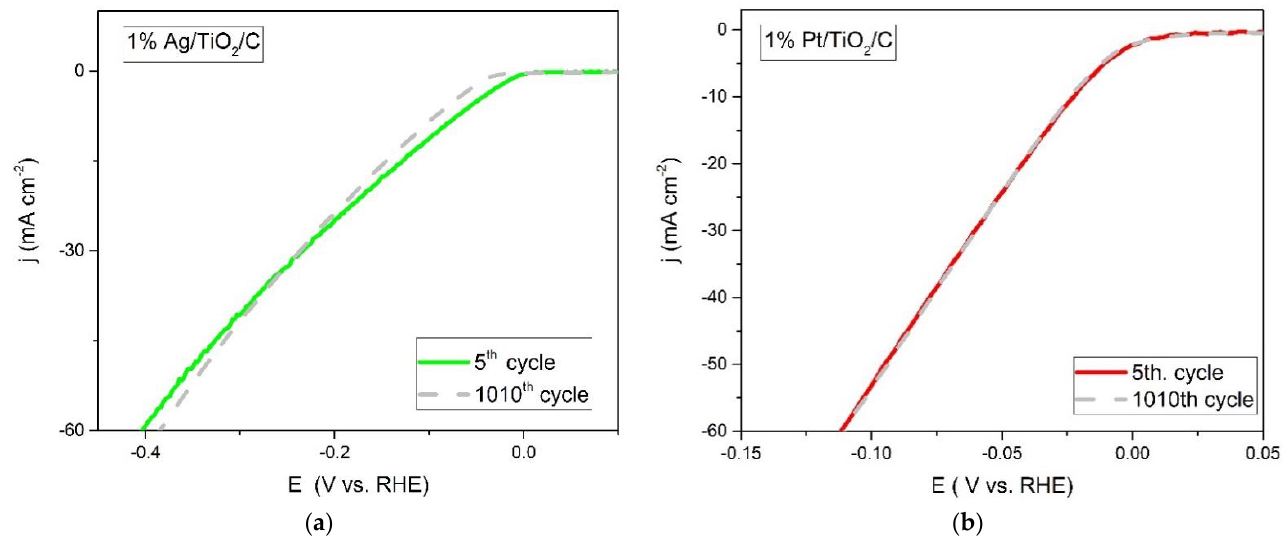
Figure 8. HER polarization curves collected before and after 1000 cycles in Ar-saturated 0.5 M H 2 SO 4 solution obtained for 1 % Ag/TiO 2 /C ( a ) and 1% Pt/TiO 2 /C ( b ). Scan rate: 5 mV s −1 . Rotation rate: 3600 rpm.